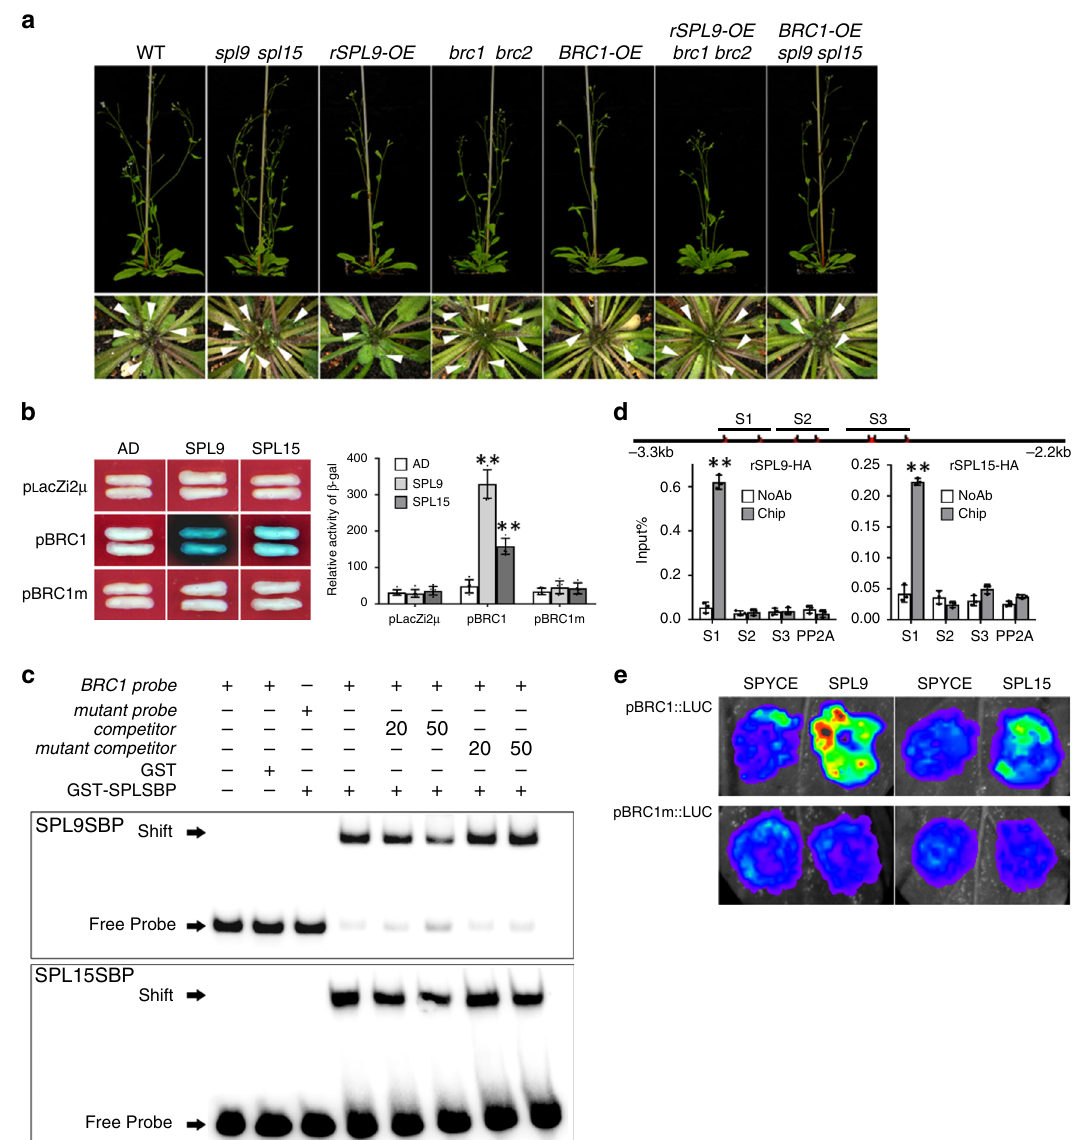
Fig. 2 SPL9 and SPL15 bind to the BRC1 promoter and inhibit shoot branching by upregulating BRC1 expression. a Comparison of the rosette branch number of WT and various mutants. Eight-day-old seedlings were moved into the soil and grown under normal conditions (WL) for 4 weeks before phenotyping. Arrow indicates the short rosette branches. b Yeast one-hybrid assay showing the binding of SPL9 and SPL15 to the full-length promoter (~3.2 kb) of BRC1 . c EMSA shows that both the GST-SPL9SBP domain (up panel) and GST-SPL15SBP domain (down panel) recombinant proteins directly bind to the biotin-labeled probe of the BRC1 promoter fragment. This assay was repeated for three times and similar results were obtained. d ChIP assay of BRC1 in 10-day-old 35 S::rSPL9-HA and 35 S::rSPL15-HA seedlings grown under normal white light conditions. Values given are mean ± SD ( n = 3). ** p < 0.01 by two-sided LSD test. e Transient expression assay of luminescence intensity show that both SPL9 and SPL15 directly enhance the expression of BRC1 . Representative images of N. benthamiana leaves 72 h after in fi ltration were shown. Five independent determinations were